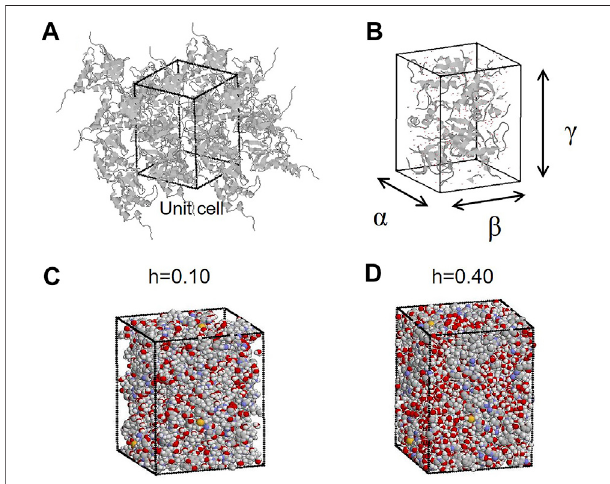
FIGURE 1 | (A) MD simulation system of protein crystals (with periodic boundary condition) of SNase. The rectangular box indicates the unit cell. (B) Lengths of the three sides of a rectangular unit cell (lattice constants) are denoted by α , β , and γ . (C and D) Proteins and water molecules in the unitcellathydrationlevelsofh (cid:1) 0.10(gwater/gprotein)andh (cid:1)